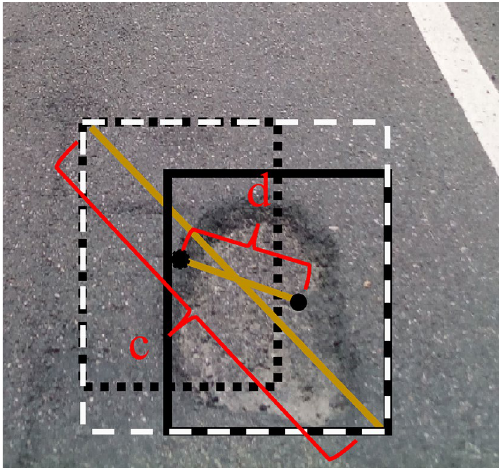
Figure 11. Normalized distance between the prediction frame and object frame.